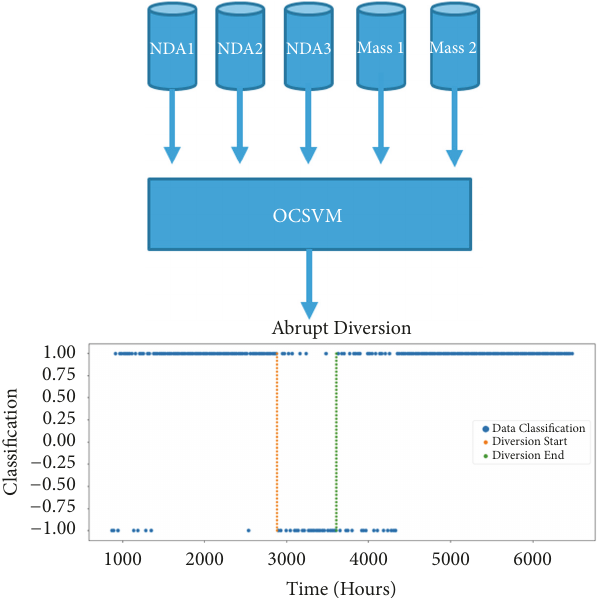
Figure 6: Illustration of the OCSVM